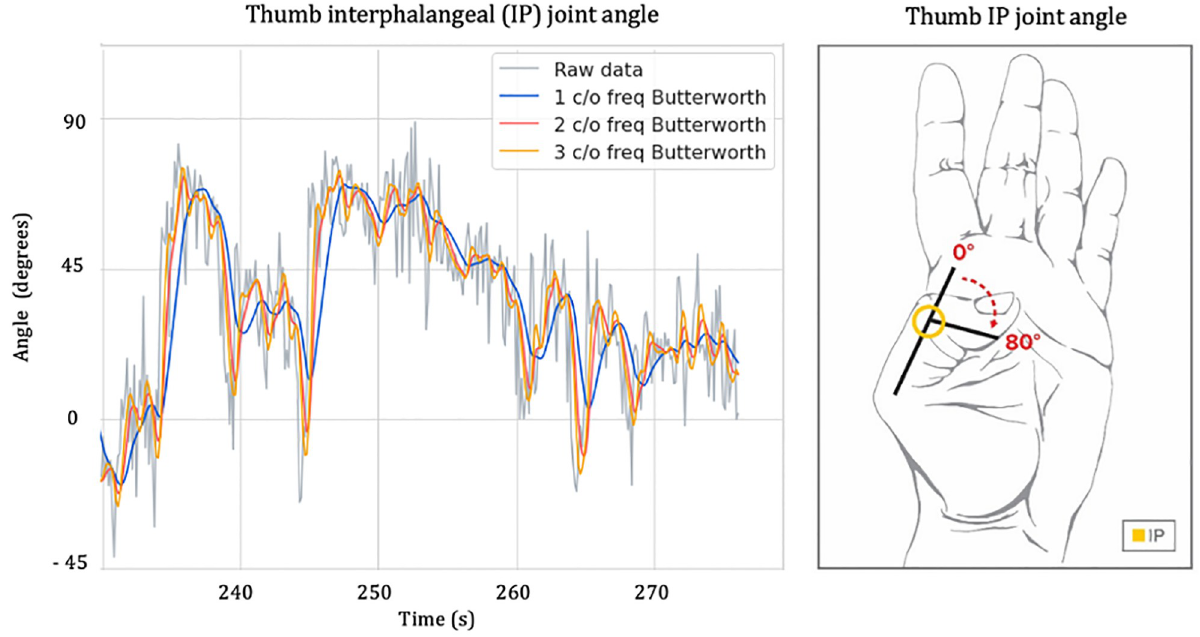
Fig 4. Butterworth filter in output from OpenPose. Butterworth filter with 1 Hz, 2 Hz and 3 Hz cut off frequencies (c/o freq.) applied to the OpenPose signal of the thumb interphalangeal joint angle for one representative